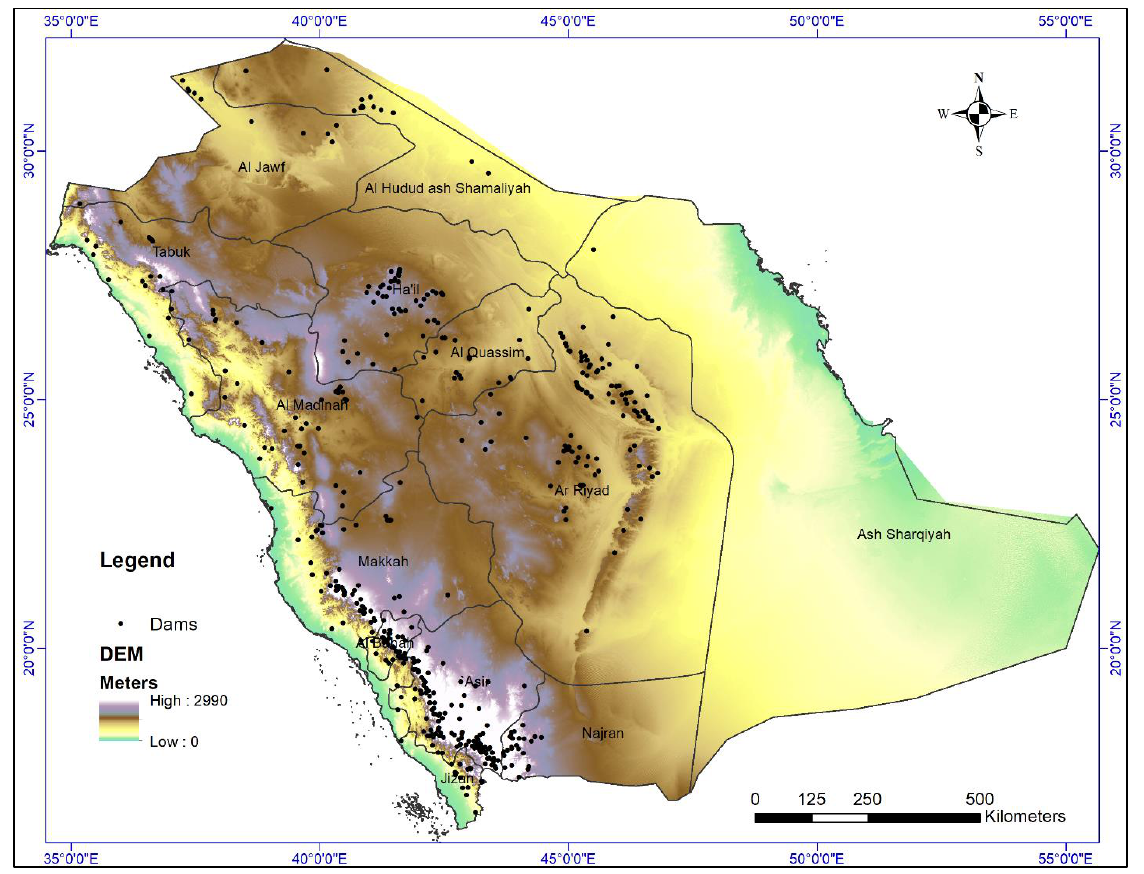
Figure 11. DEM and existing dams in Saudi Arabia.